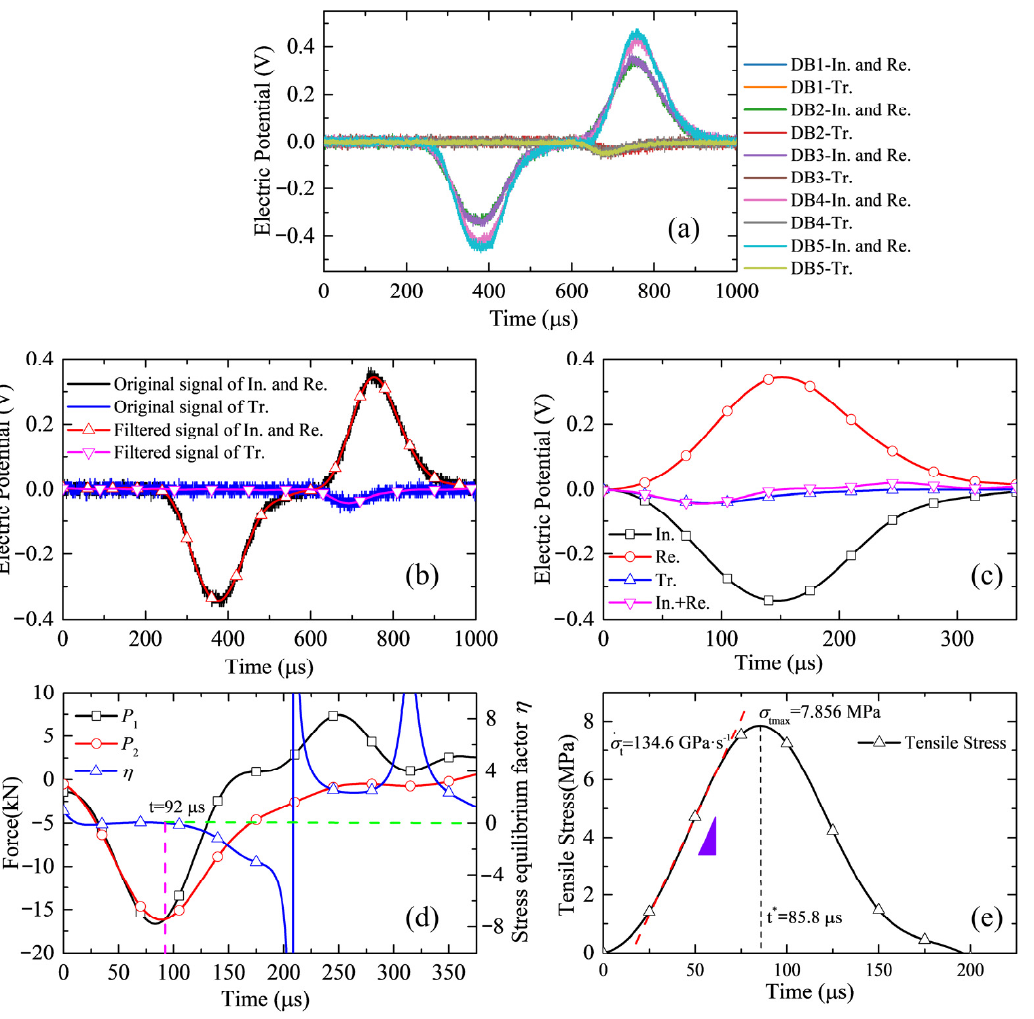
Figure 3. Experimental results for the Breccia specimen. ( a ) Raw signals of the Brazilian test. ( b ) Raw and filtered signal at a striking velocity of 4.86 m/s. ( c ) The incident (In.), reflected (Re.), transmitted (Tr.), and superposed (In. + Re.) waves. ( d ) Verified stress equilibrium. ( e ) Determination of dynamic tensile strength and loading rate.